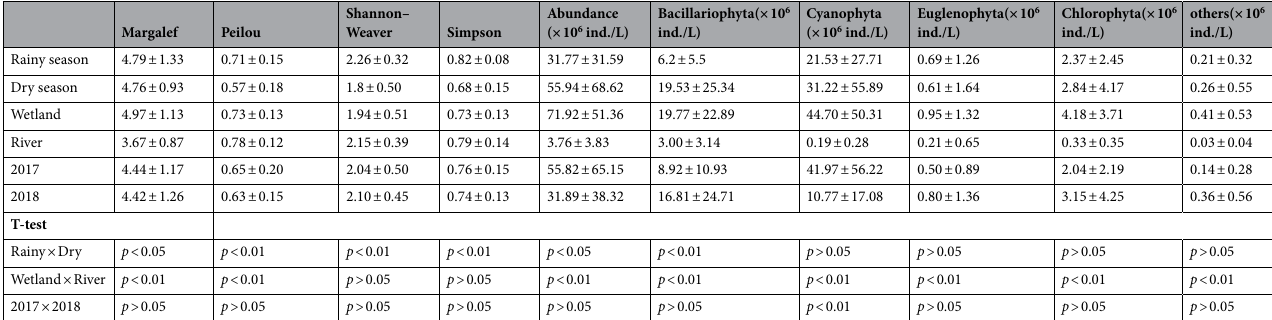
Table 2. The temporal and spatial variation of phytoplankton alpha diversity indices and phytoplankton community structure during study period.